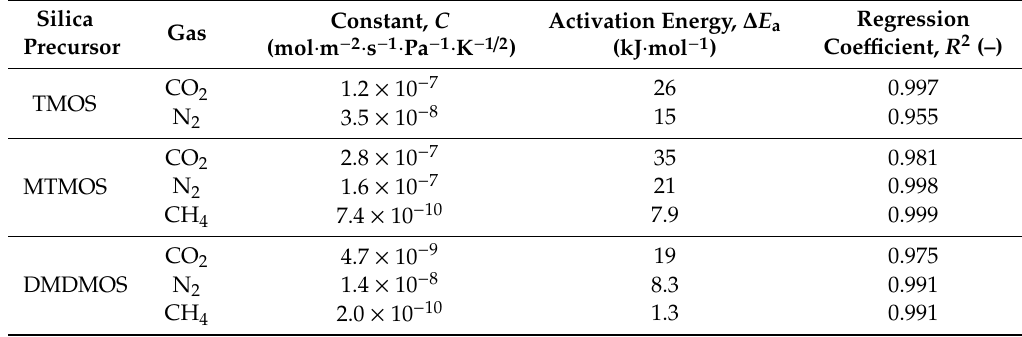
Table 6. Model factors calculated by fitting the membrane permeances to the gas-translational di ff usion model Equation (7).